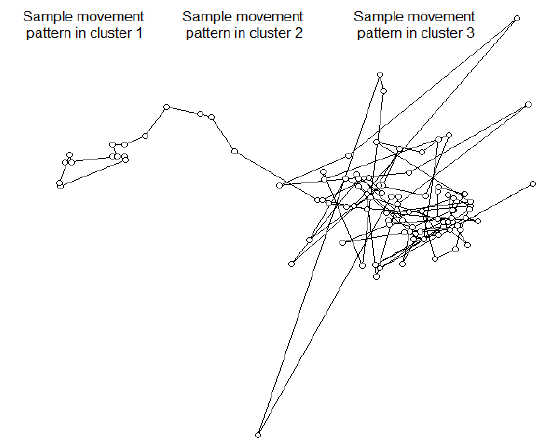
cluster 3, Figure 2. An illustration of the three cluster type movements: cluster 1, resting; cluster 2, traveling; cluster 3, foraging.